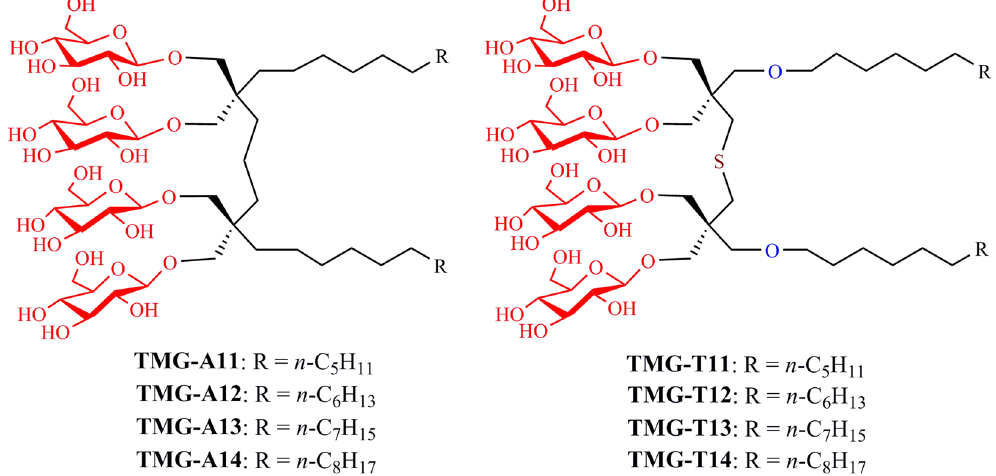
Figure 1. Chemical structures of the tandem malonate glucosides (TMGs). Two malonate units were connected via a propylene linker in the case of the TMG-As or via a dimethyl sulfide linker for the TMG-Ts. The alkyl chain length varied from C11 to C14 for both sets of TMGs, and this was incorporated into the detergent